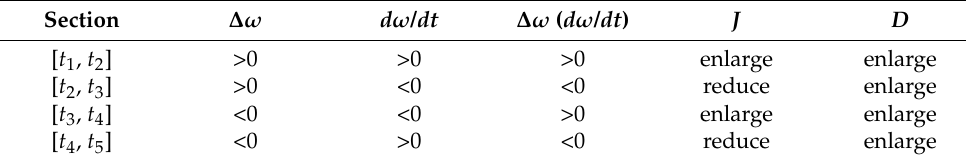
Table 1. Selection rules of J and D